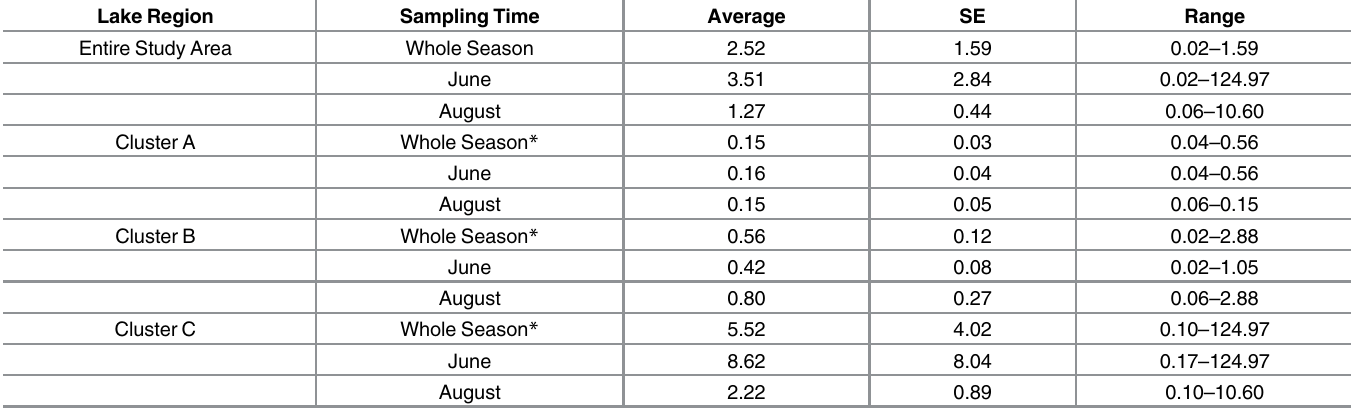
Table 2. Methane concentrations ( μ mol L -1 ) across the study region in southwest Greenland.